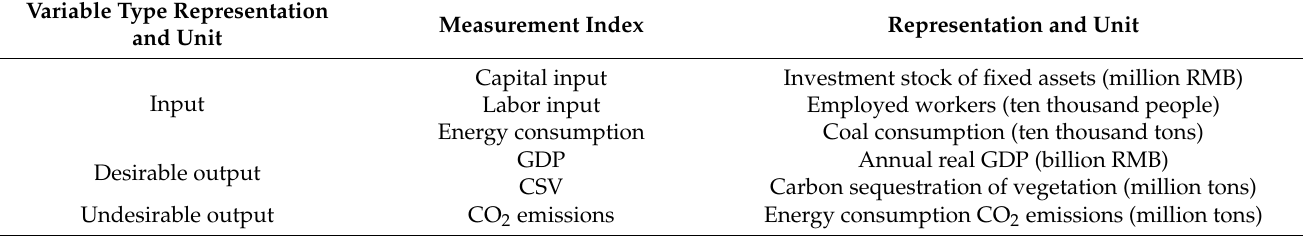
Table 2. The input–output index